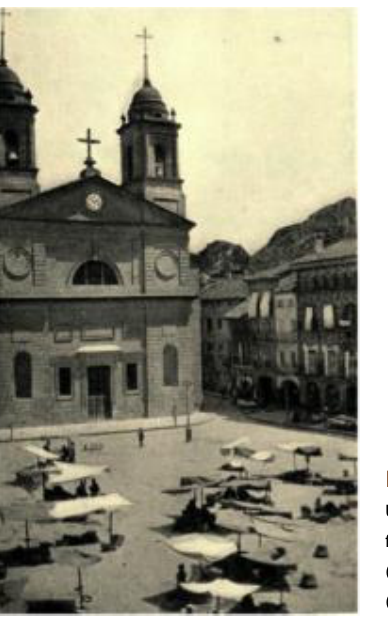
Figure 12 Unidentified photographer, The Thursday Market in Estella , from Georgiana Goddard King, The Way of Saint James , vol. 1 (New Y ork: G.P. Putnam’s Sons, 1920) opposite page